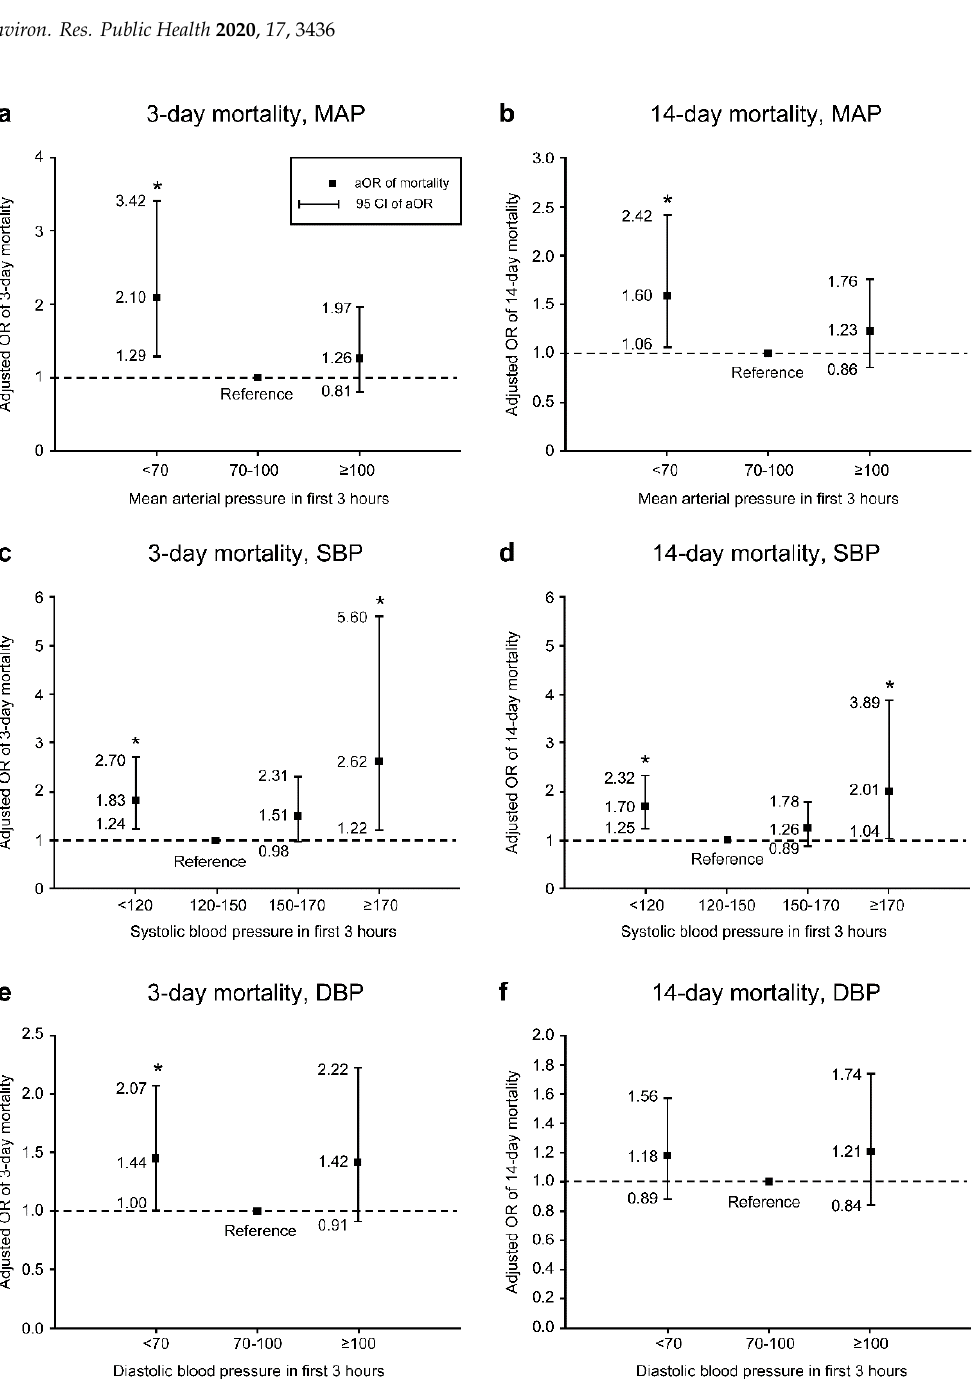
Figure 2. The adjusted odds ratio (aOR) of mortality in patients with non-traumatic hemorrhage ( n = 1493). ( a ) aOR of 3-day mortality in MAP levels, ( b ) aOR of 14-day mortality in MAP levels, ( c ) aOR of 3-day mortality in SBP levels, ( d ) aOR of 14-day mortality in SBP levels, ( e ) aOR of 3-day mortality in DBP levels, ( f ) aOR of 14-day mortality in DBP levels. aORs were adjusted for sex, care-unit, age, sepsis, and Sequential Organ Failure Assessment score. MAP, mean arterial pressure; SBP, systolic blood pressure; DBP, diastolic blood pressure; OR, odds ratio; CI, confidence interval; *, p <